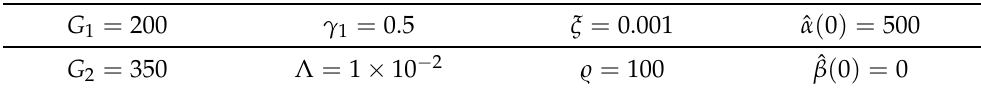
Table 3. Control parameters of AISOSMC.